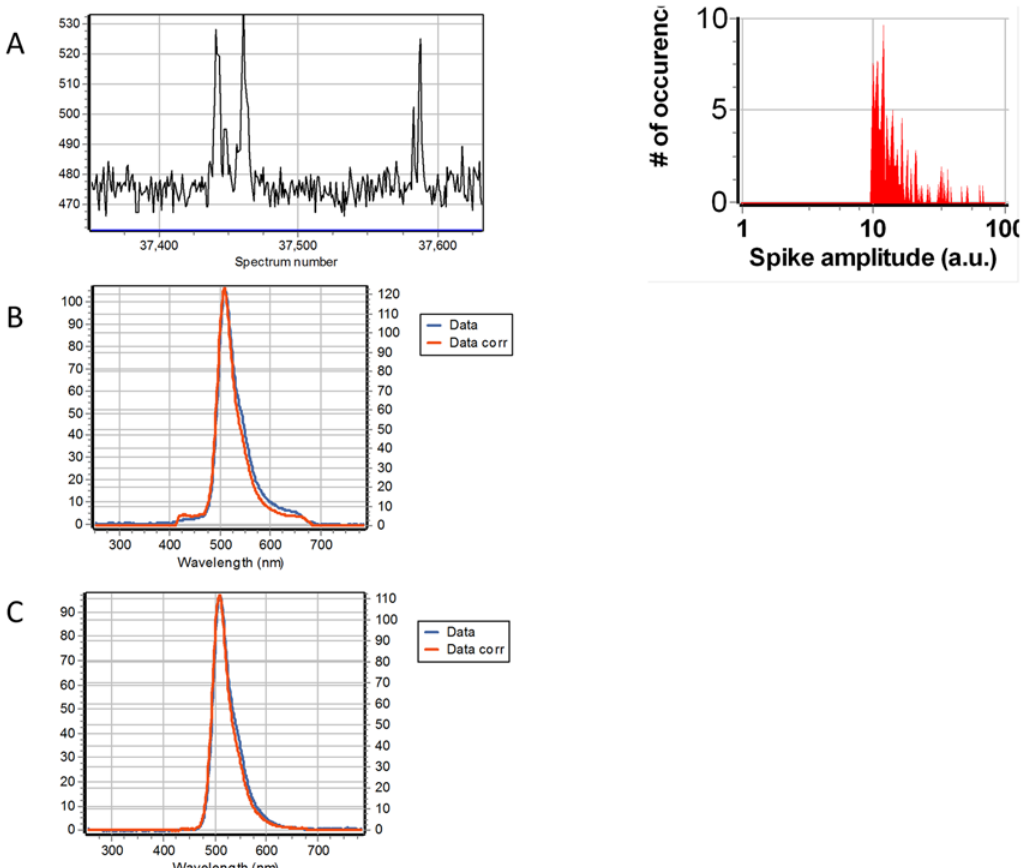
Fig 8. 1 nM AuNP suspension in the presence of 100nM EGFP. The excitation wavelength was 890 nm. In all graph the vertical axis is in intensity units from the Andor camera. (A) Intensity trace of a small region of the overall data collection. The intensity is obtained by the integrating the spectrum from 420nm to 680nm. A total of 500,000 spectra were collected every 200 microseconds. Occasional burst are observed along the intensity trace above the average spectral intensity due to EGFP in solution. (B) The average spectrum of 144 intensity bursts. (C) Average spectrum of the regions of the trace without bursts. The spectra in B and C are very